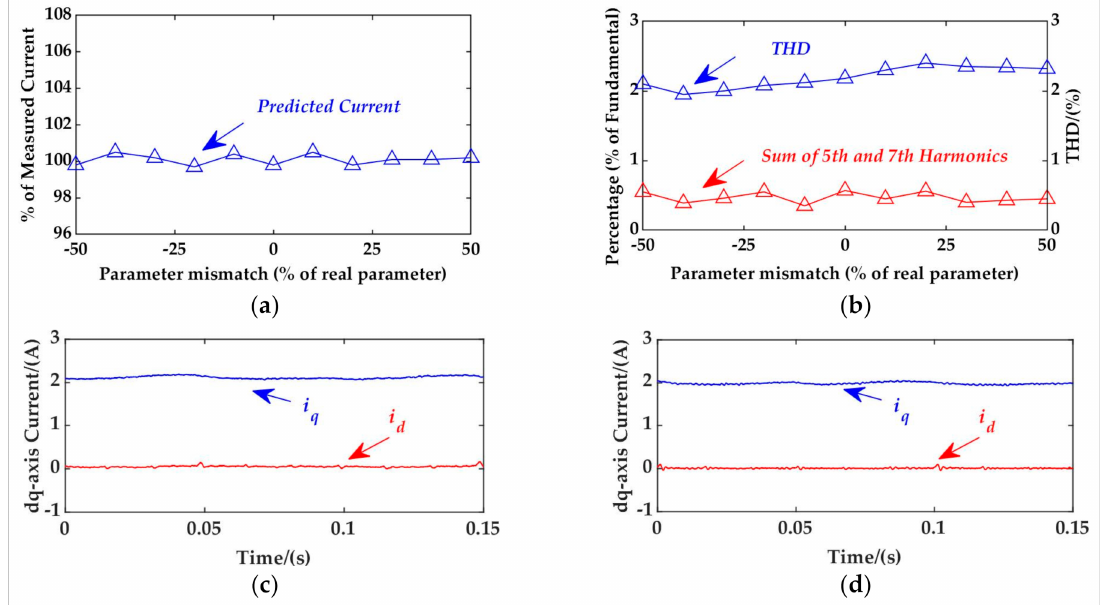
Figure 21. Test results under mismatched stator inductance. ( a ) Ratio of percentage of predicted current versus measured current. ( b ) THD, 5th and 7th harmonics of phase A current. ( c ) dq –axis currents under − 50% stator inductance error. ( d ) dq –axis currents under 50% stator inductance